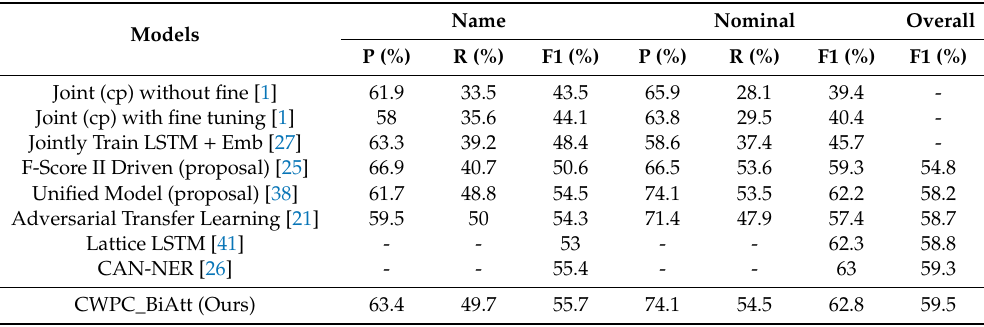
Table 5. In first block, perimental results of previous models on Weibo NER corpus. In second block, the result of our CWPC_BiAtt model on Weibo NER